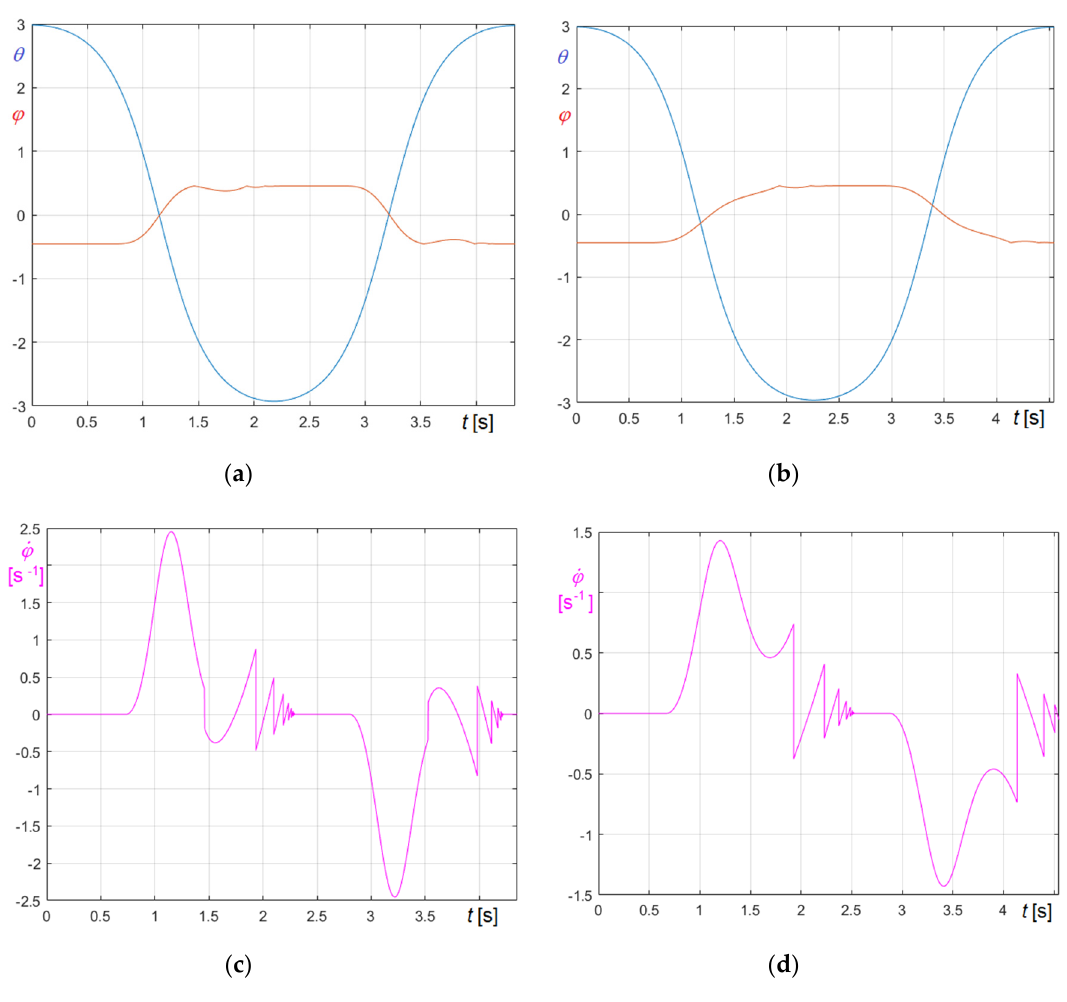
Figure 9. First cycle of bell oscillations and clapper strikes for bells 2 and 3 ringing wrong: ( a ) θ = θ ( t ) and ϕ = ϕ ( t ) curves obtained with the proposed algorithm for bell 2; ( b ) θ = θ ( t ) and ϕ = ϕ ( t ) curves obtained with the proposed algorithm for bell 3; ( c ) . ϕ = . ϕ ( t ) curve obtained with the proposed algorithm for bell 2; ( d )